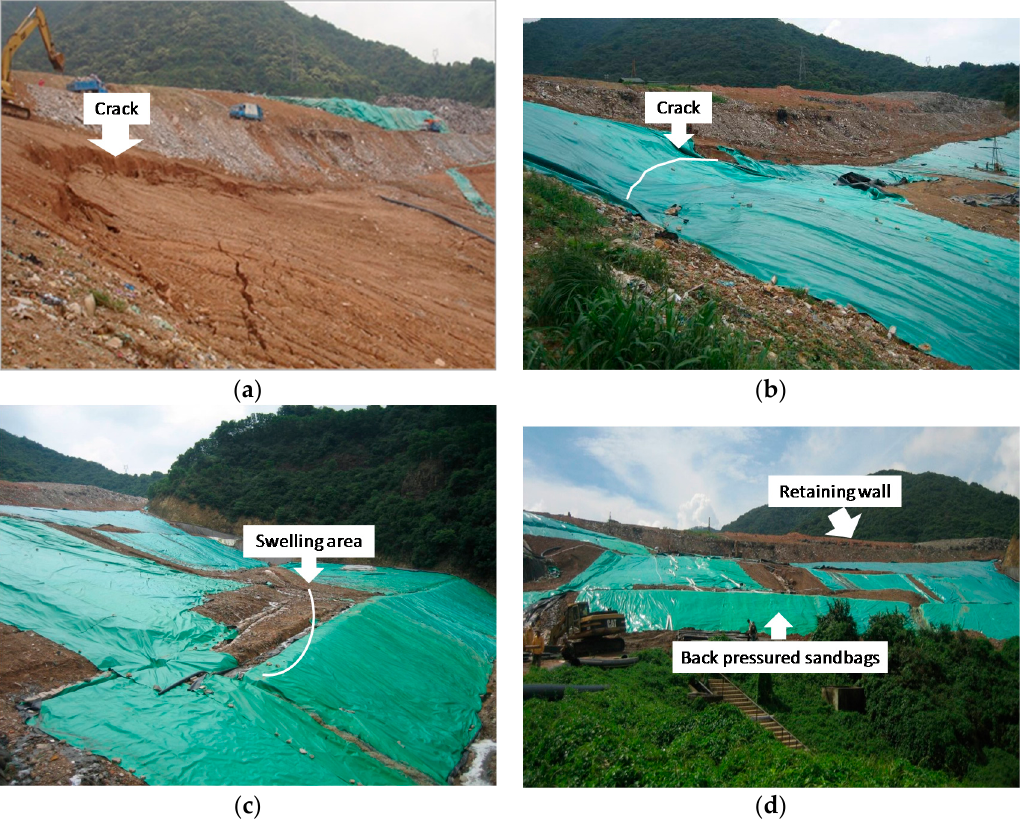
Figure 4. Shenzhen landfill in June 2008 ( a ) Crack at the trailing edge of waste body; ( b ) Plastic mulch paved on the waste body surface; ( c ) Swelling area; ( d ) Retaining wall.